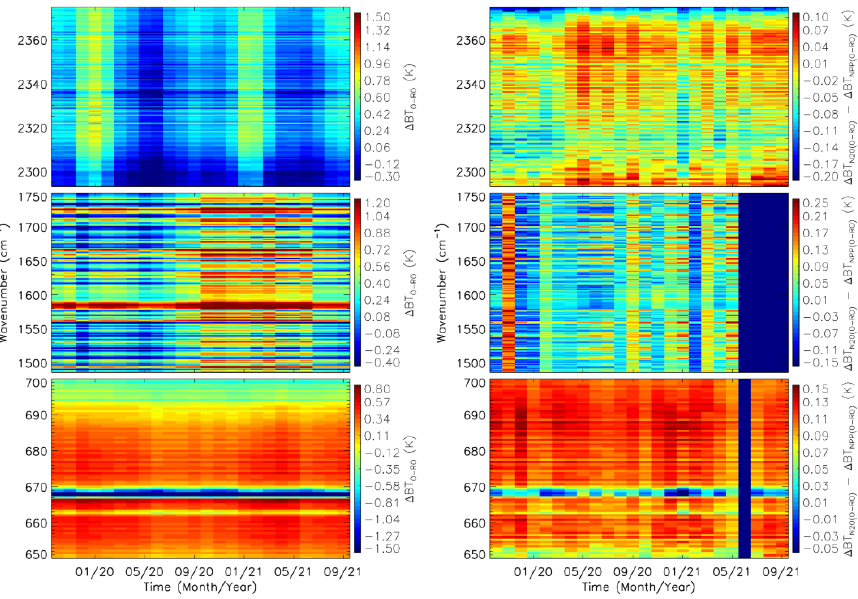
Figure 12. ( left ) Monthly mean BT difference between NOAA-20 CrIS observations and simulations with UCAR RO data; ( right ) two CrIS double differences between NOAA-20 and S-NPP using simulations with UCAR RO data as a transfer. Note that the data gaps in the LWIR band during June 2021 and the MWIR band after June 2021 are due to S-NPP CrIS electronics failure. S-NPP CrIS operated on Side-2 electronics after 24 June 2019, when the MWIR band failed on Side 1. From 21 May to 12 July 2021, the LWIR band failed on Side 2. Since then, CrIS on S-NPP has been switched back to Side 1.